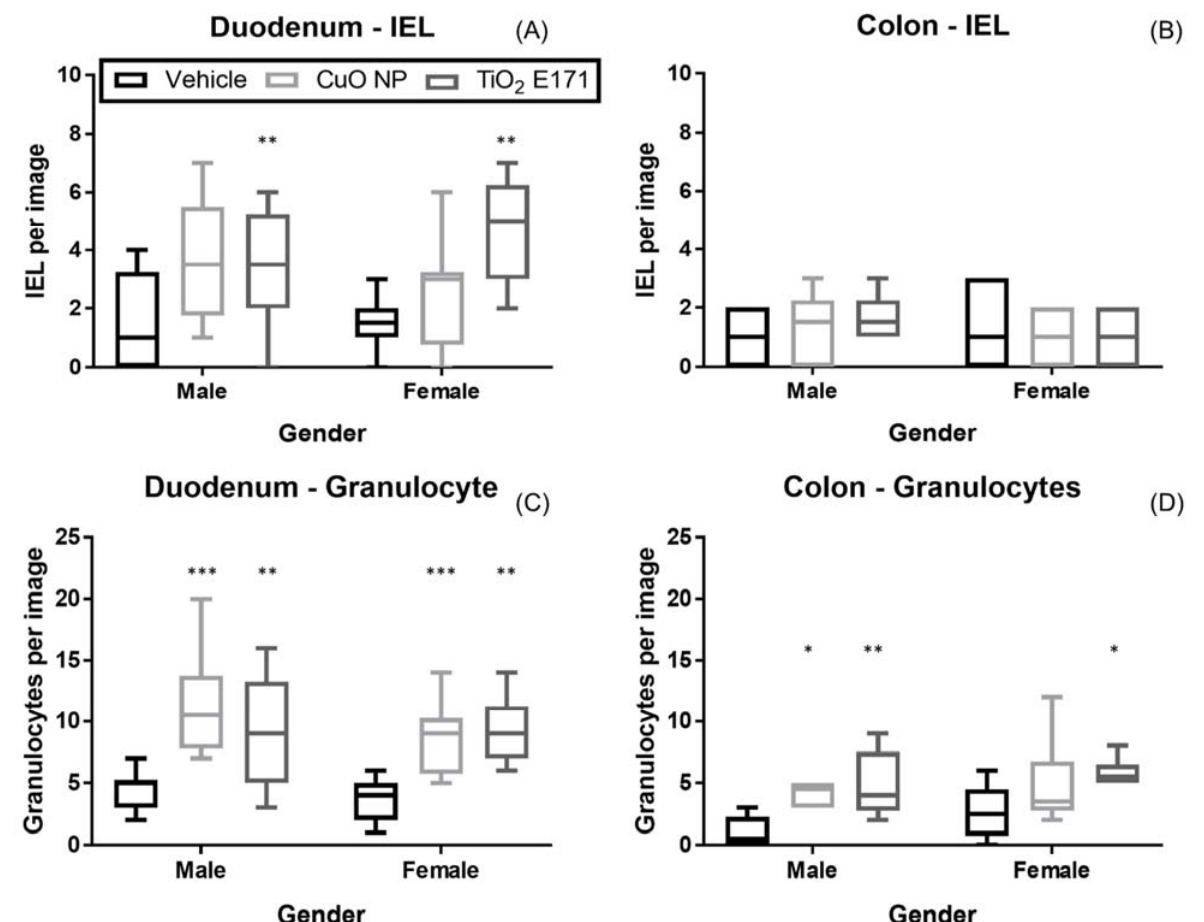
Figure 5. Immune cells, intraepithelial lymphocytes (IEL) ( A , B ) and granulocytes ( C , D ) located in H&E stained Swiss roll tissue sections of the duodenum ( A , C ) and colon ( B , D ) following oral administration of vehicle control, CuO NP, or TiO 2 E171 in male and female pups at PND 10. Box and whisker plots of number of immune cells per image are shown. Statistical difference between vehicle control and dosing groups are noted by asterisk(s), p -value < 0.05 is noted with one asterisk, p -value < 0.01 with two asterisks, and p -value < 0.001 with three asterisks. Table 3. Two ‐ way ANOVA was used to analyse the effects of gender and dose group on the number of intestinal immune cells.